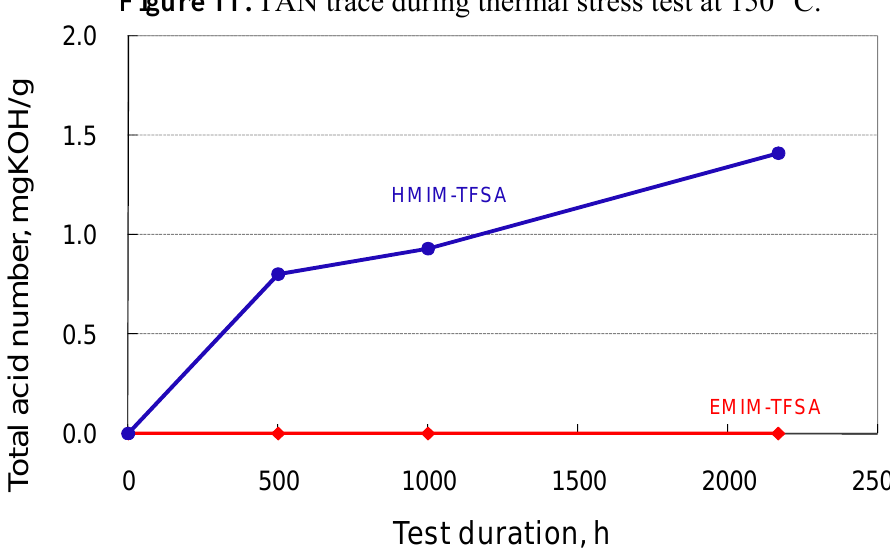
Figure 11. TAN trace during thermal stress test at 150